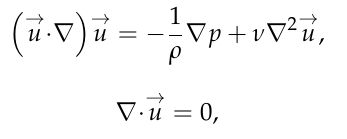
Figure 2. Schematic diagram of present micromixer (non-proportional): ( a ) 3D view and ( b ) Frontal view.